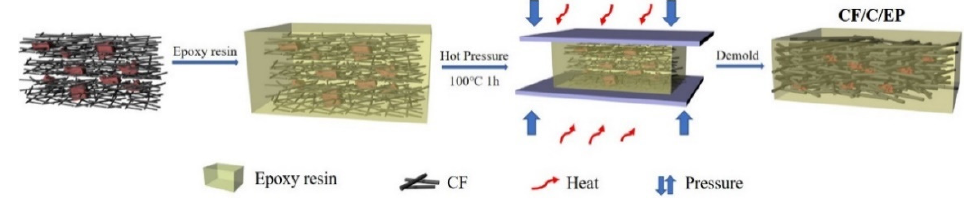
Figure 2. The preparation process of the CF/C/Epoxy (CF/C/EP) composite.